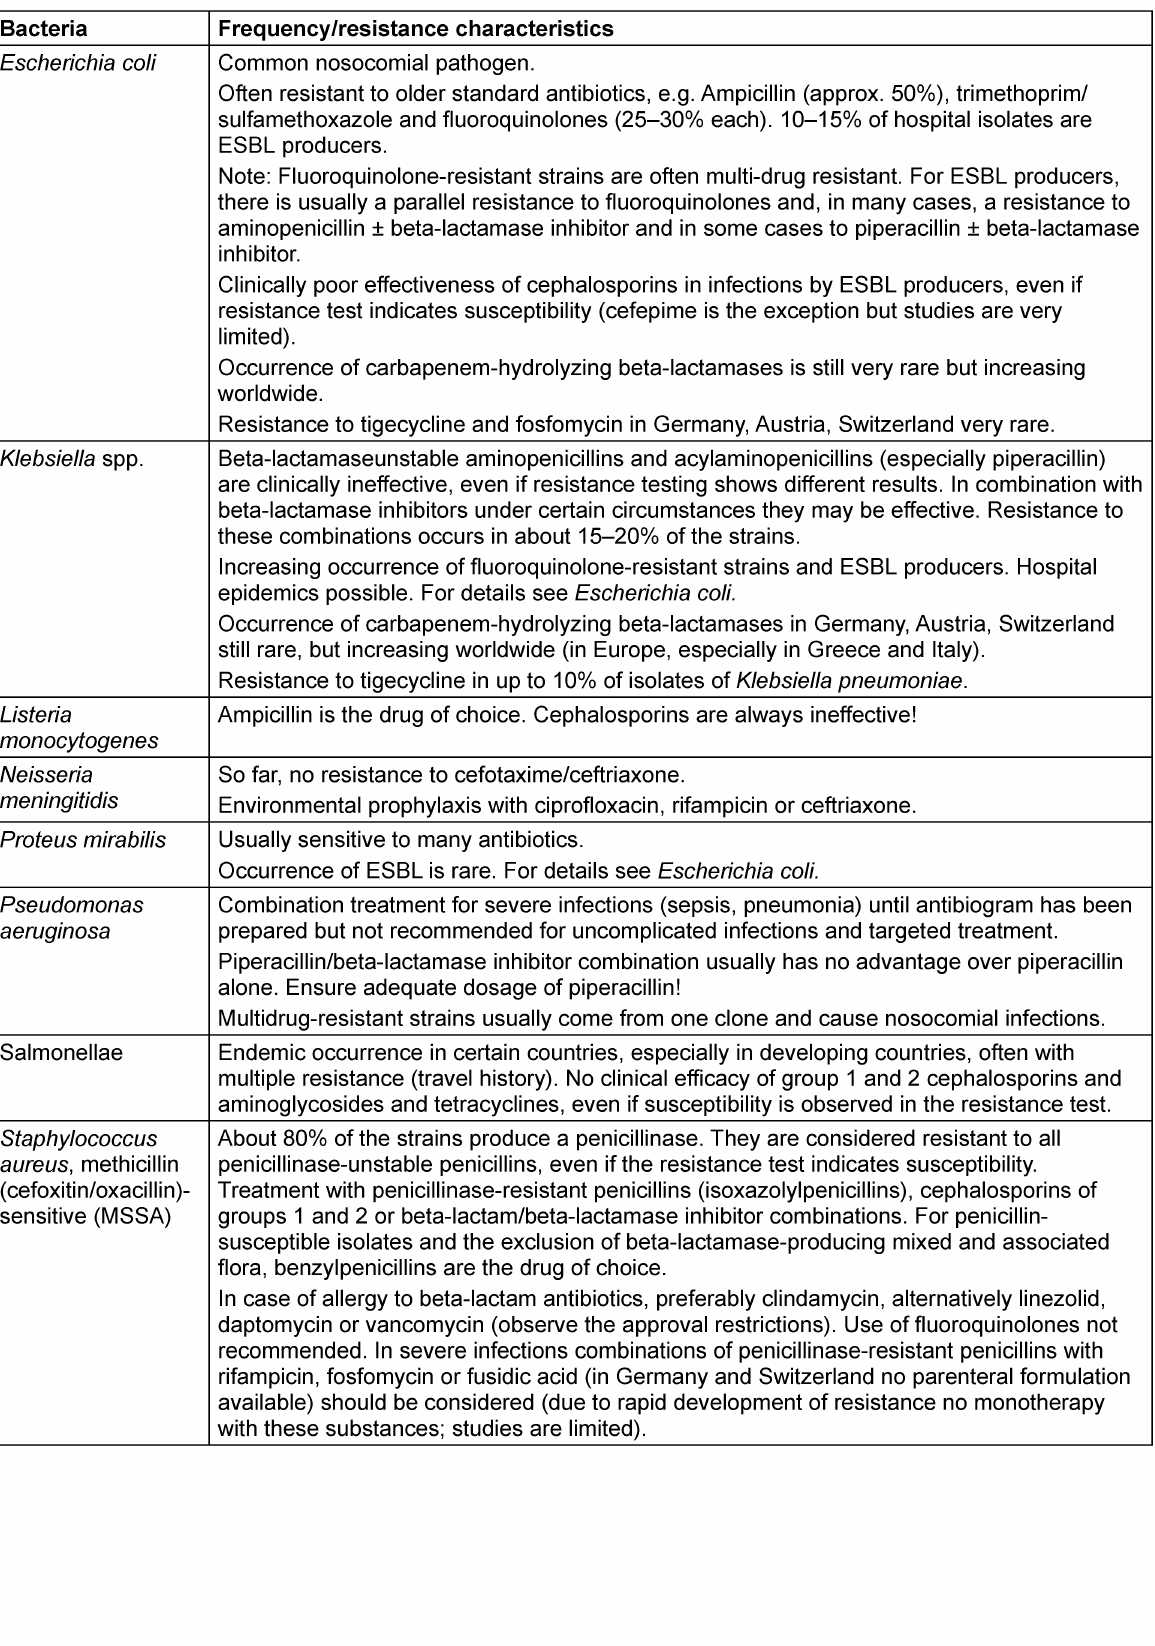
Table 2: Information on the resistance situation in important bacterial